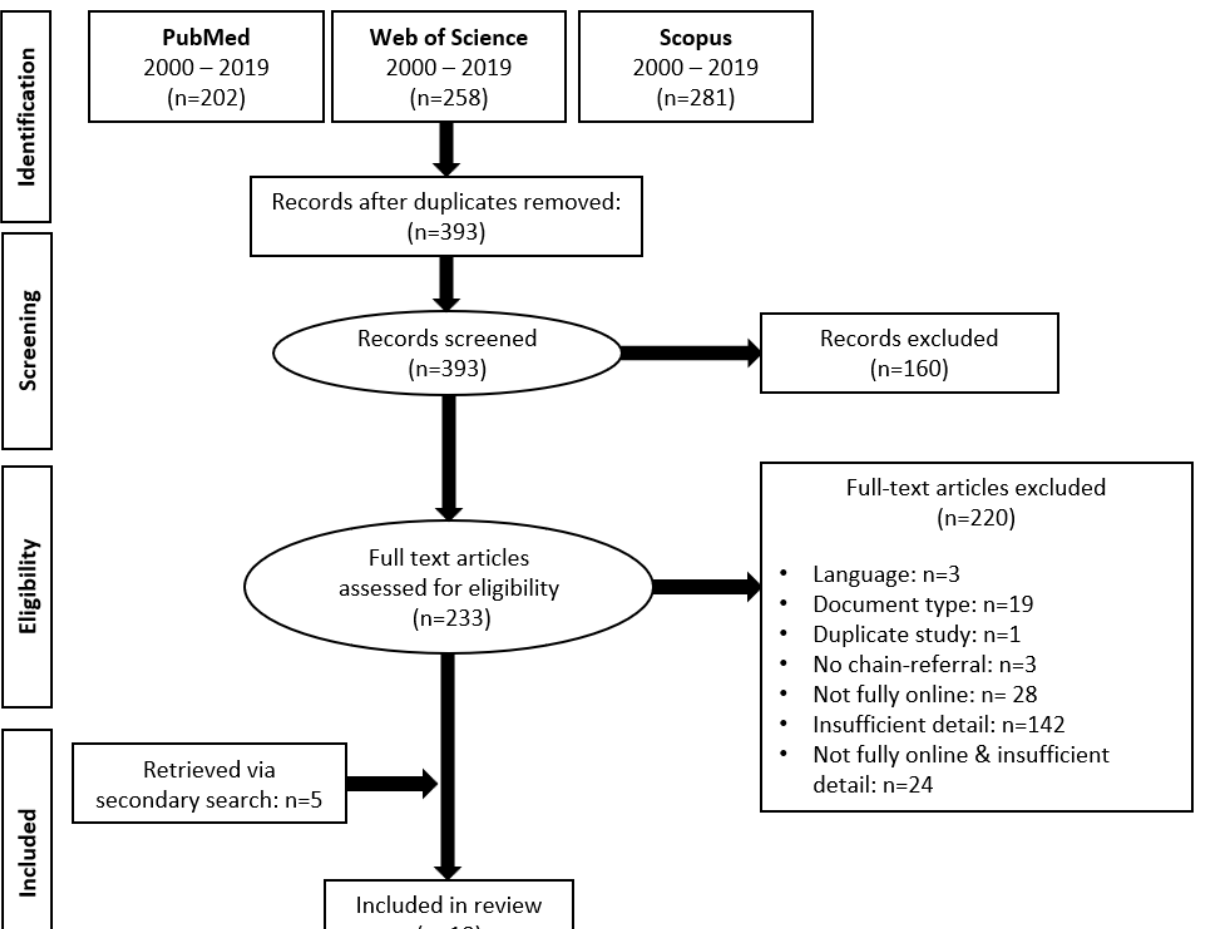
Figure 2. PRISMA